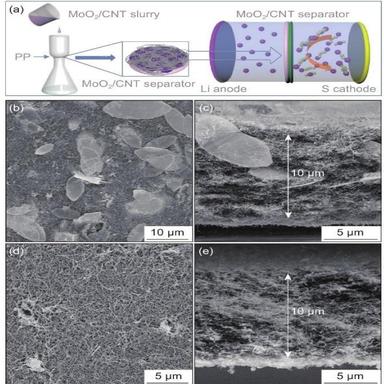
a) Schematic of the synthesis of the MoO2/CNT coated separator and its function in LSBs, SEM images of typical (b) top-view and (c) cross-sectional image of the MoO2/CNT modified separator, SEM images of typical (d) top-view and (e) cross-sectional image of the CNT modified separator.